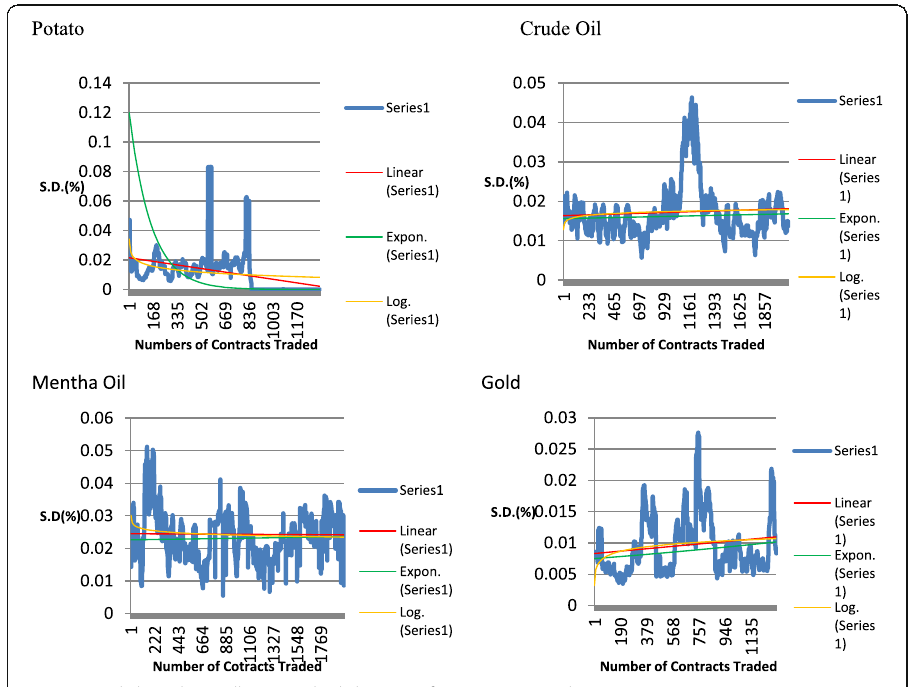
Fig. 1 Trends based on rolling standard deviation for 1 (Near) month